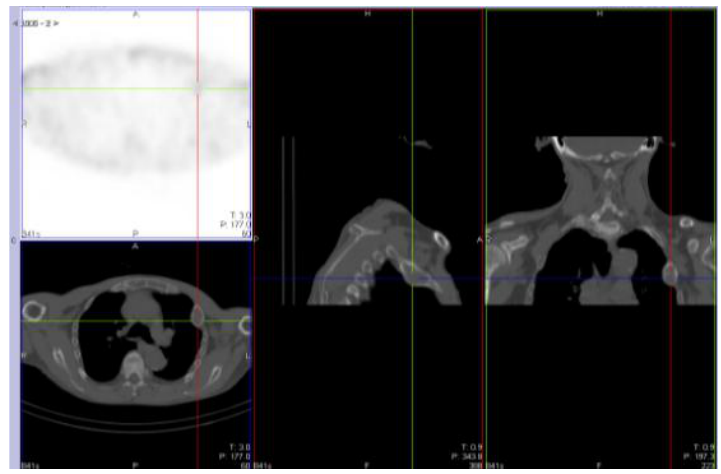
Fig. 6 99m Tc-MIBI SPECT-CT image of the brown tumor in the second rib on the left side